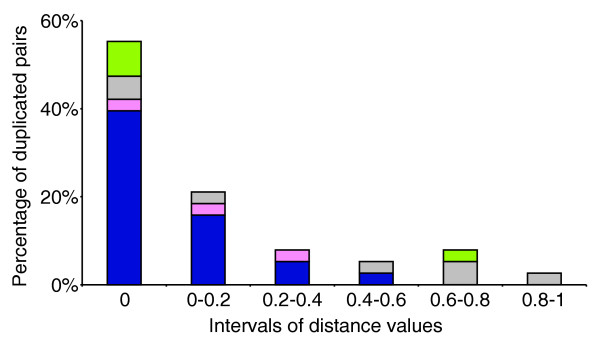
Repartition of the 3 different PRODISTIN behaviors in respect to the distribution of the GO-based functional distances (ranging from 0 to 1) between the 41 duplicated pairs. Behaviors are classified as: same class, same function (behavior I, blue); different classes, same function (behavior II, pink); different classes, different functions (behavior III, gray); not classified (green). Results are shown for the Biological Process annotations only.